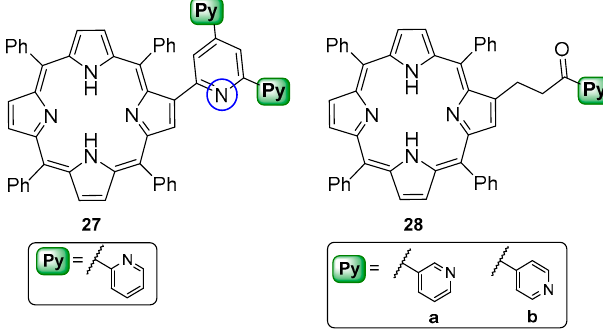
β -CHOTPP with acetylpyridines [108].